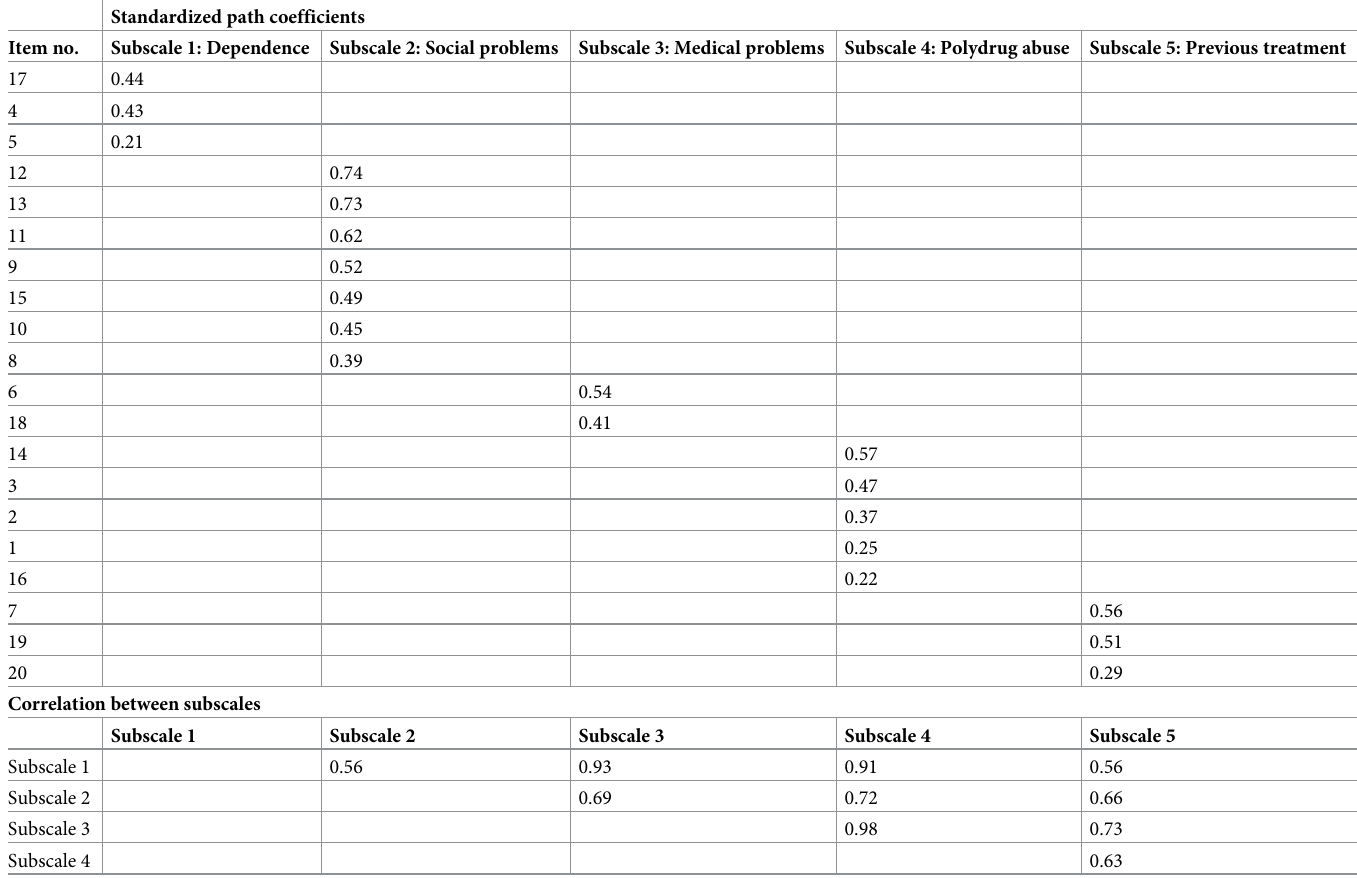
Table 3. Confirmatory analysis and model fit of the Drug Abuse Screening Test-20. Standardized path